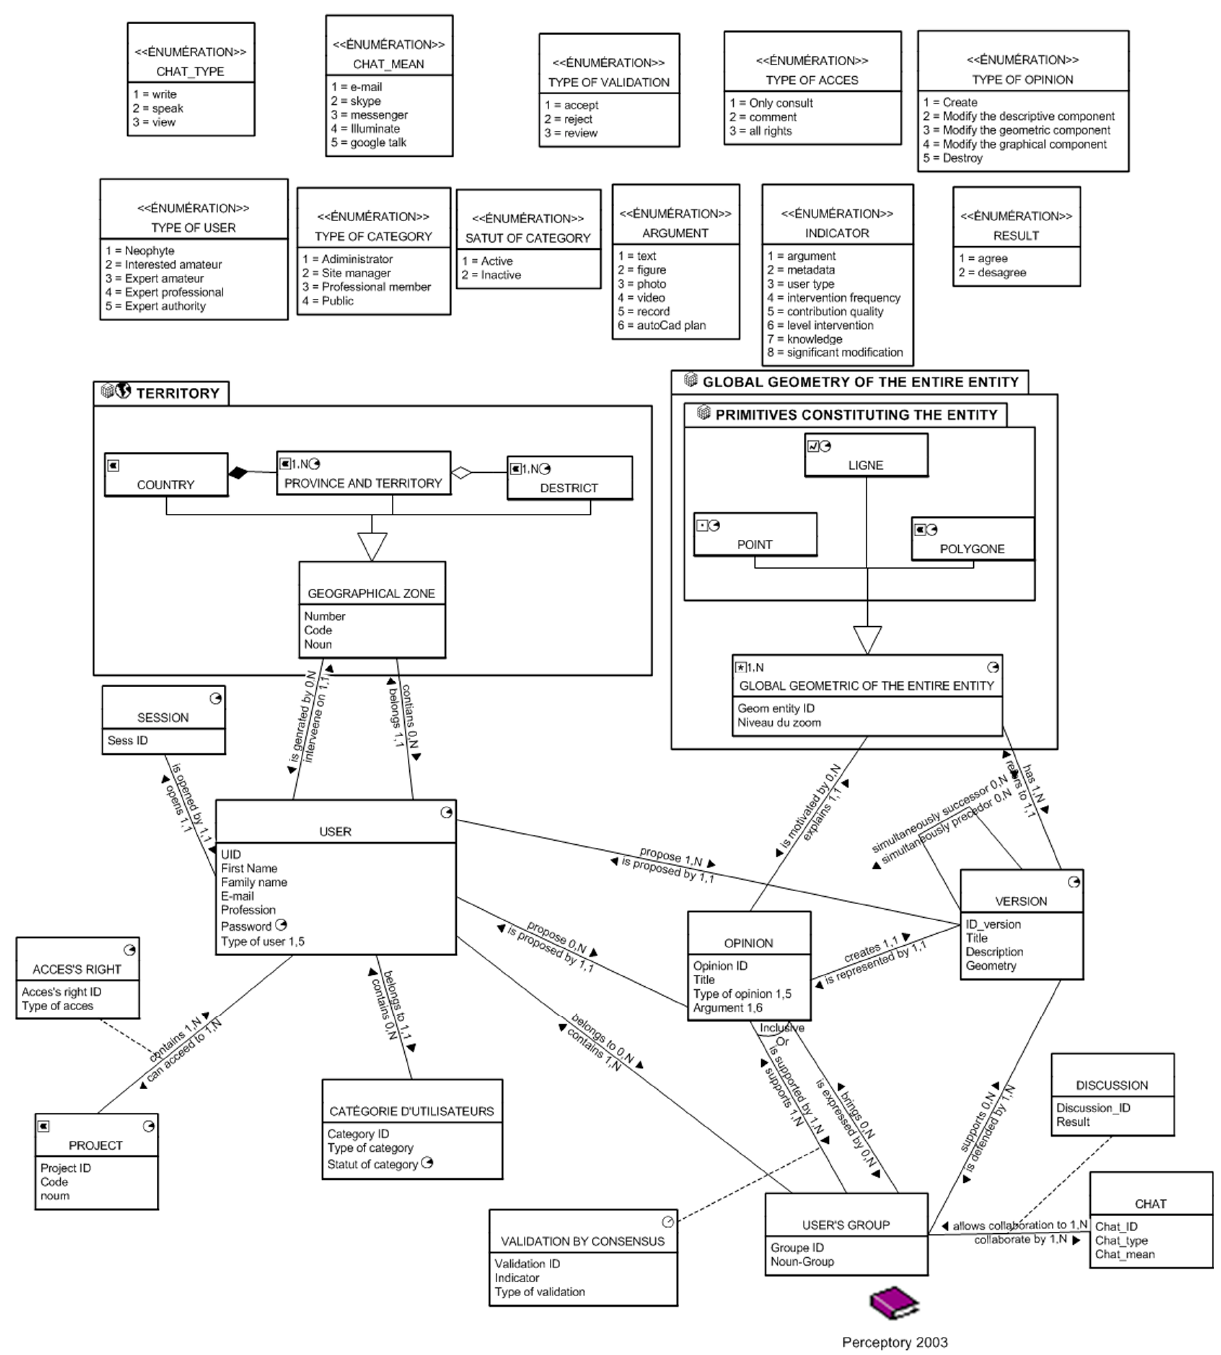
Figure 10. The CIM level of